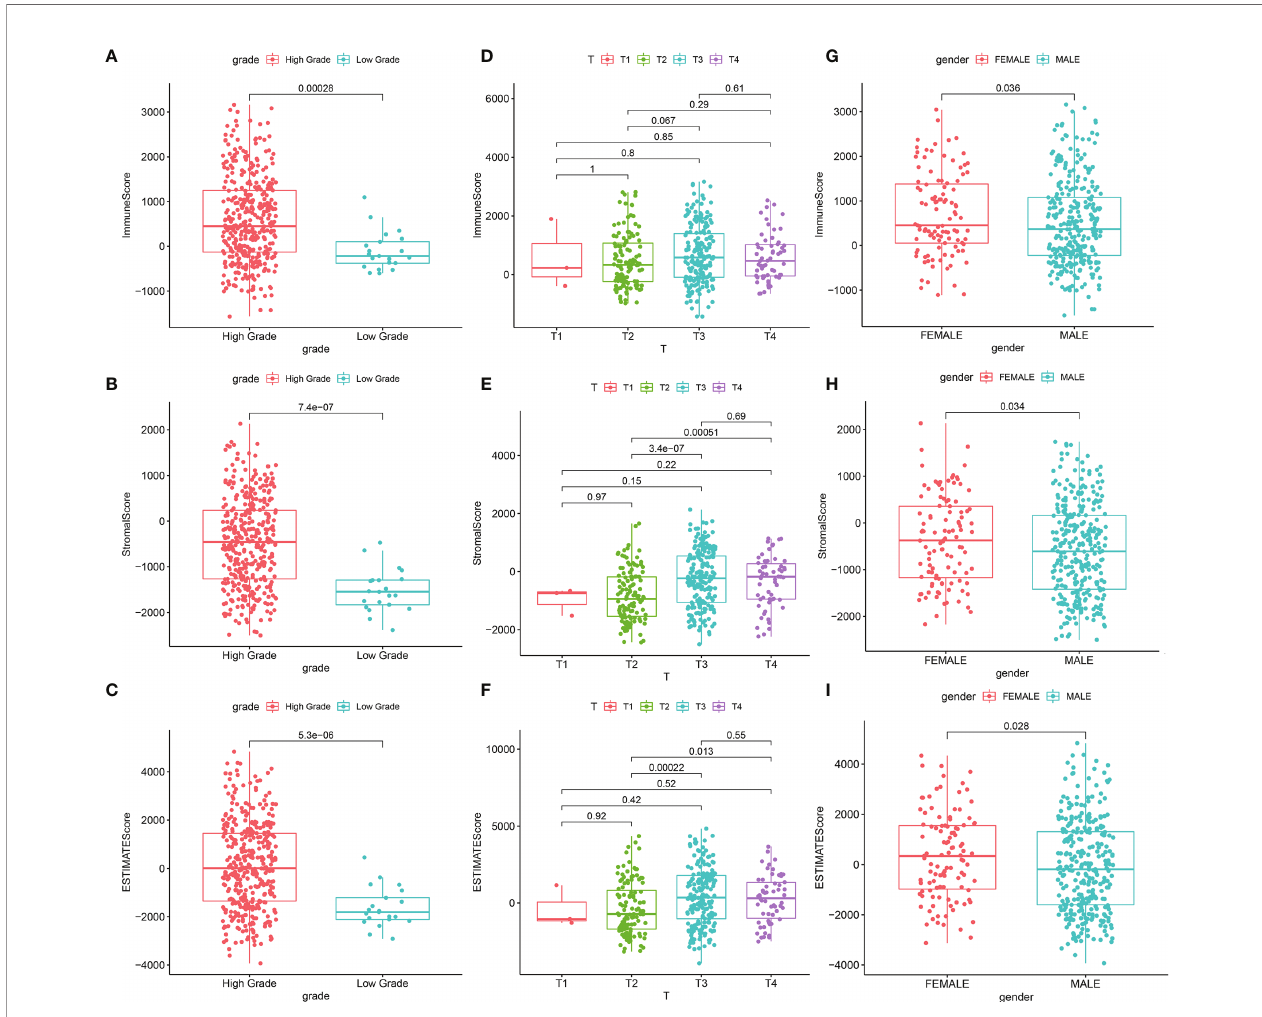
FIGURE 2 | Signi fi cant correlation between clinicopathological characteristics and scores. (A – C) Correlation between the scores and grade. (A) Distribution of ImmuneScore in grade ( p = 0.00028). (B) Distribution of StromalScore in grade ( p = 7.4e − 07). (C) Distribution of ESTIMATEScore in grade ( p = 5.3e − 06). (D – F) Correlation between scores and T classi fi cation. (D) Distribution of ImmuneScore in T classi fi cation. (E) Distribution of StromalScore in T classi fi cation. (F) Distribution of ESTIMATEScore in T classi fi cation. (G – I) Correlation between scores and gender. (G) Distribution of ImmuneScore in gender ( p = 0.036). (H) Distribution of StromalScore in gender ( p = 0.034). (I) Distribution of ESTIMATEScore in gender ( p =